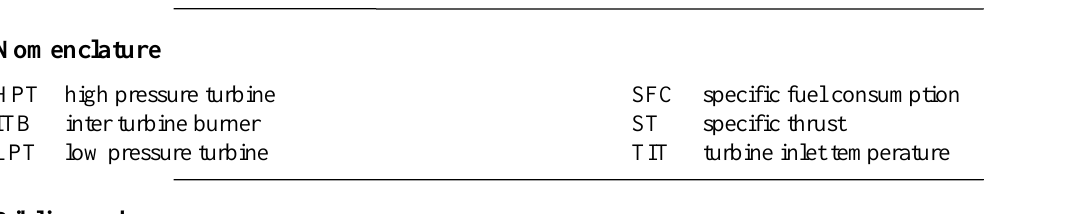
Fig. 4. Specific thrust and specific fuel consumption in function of LPT inlet